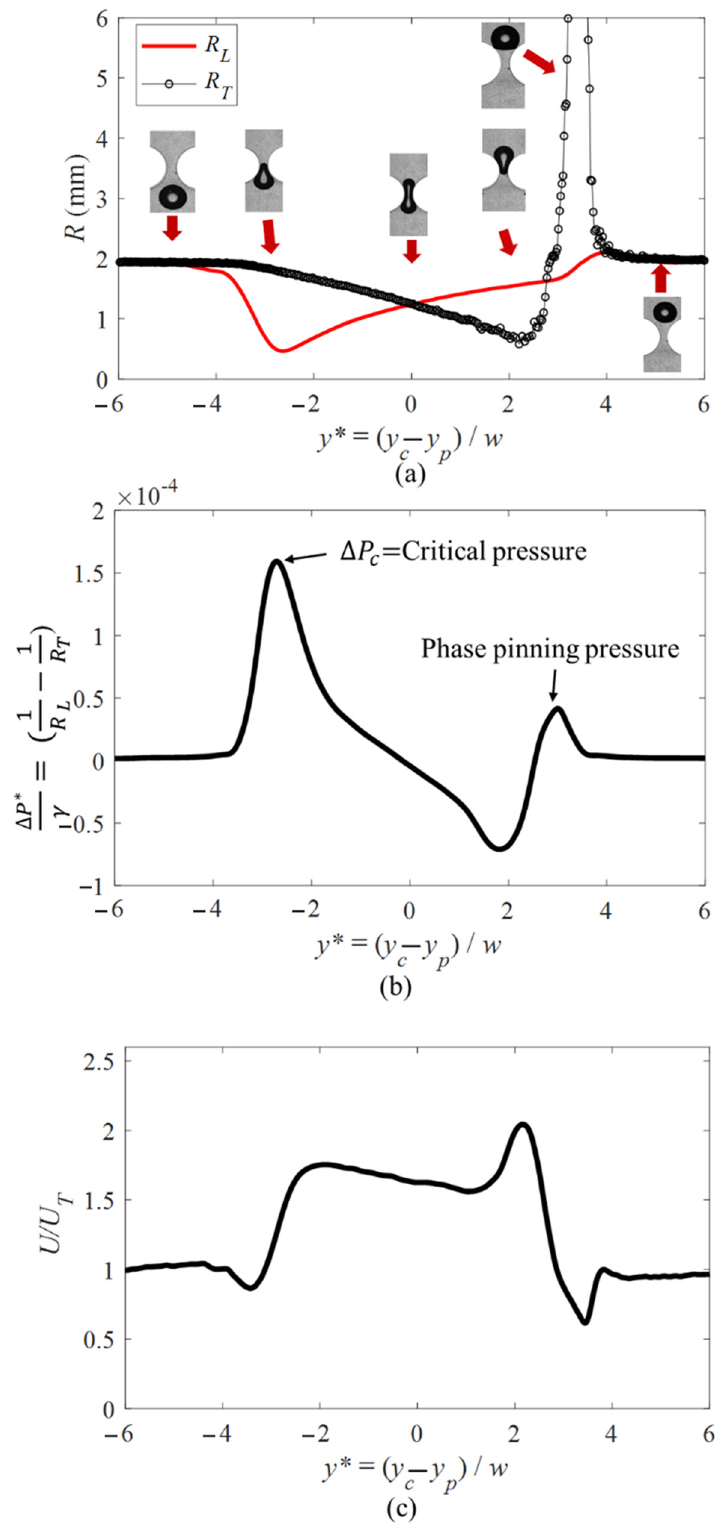
Figure 9. Plots of ( a ) change in the radii of curvature of leading and trailing edge of a bubble, ( b ) pressure along the bubble, and ( c ) velocity of the centroid of the projected area of a bubble ( R b ∼ 1.95 mm) passing through a smooth circular pore surface. (Sample images of different conditions are shown in Figure 6I).